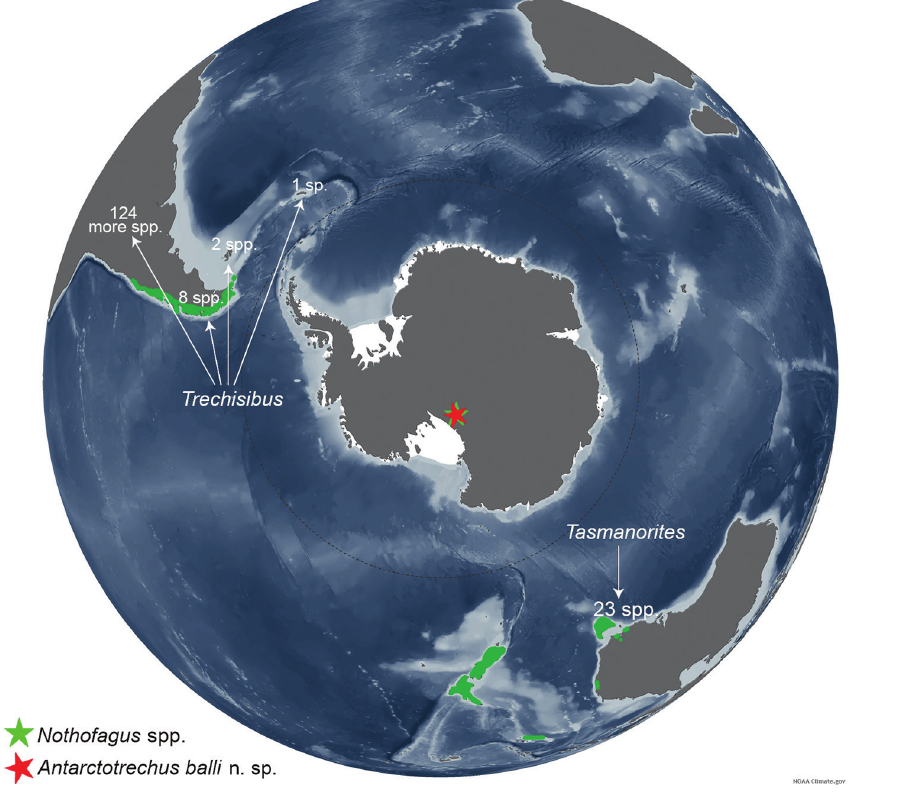
Figure 8. The distribution of extant species of Trechisibus, Tasmanorites and Nothofagus and the fossil oc- currence of A. balli sp. n. and Nothofagus beardmorensis on the Beardmore Glacier shown by red and green stars: information for Trechisibus species (Allegro et al., 2008) and Tasmanorites (Eberhard S, Giachino, PM, 2011). Base image: NOAA Climate.gov https://www.climate.gov/news-features/understanding-cli-